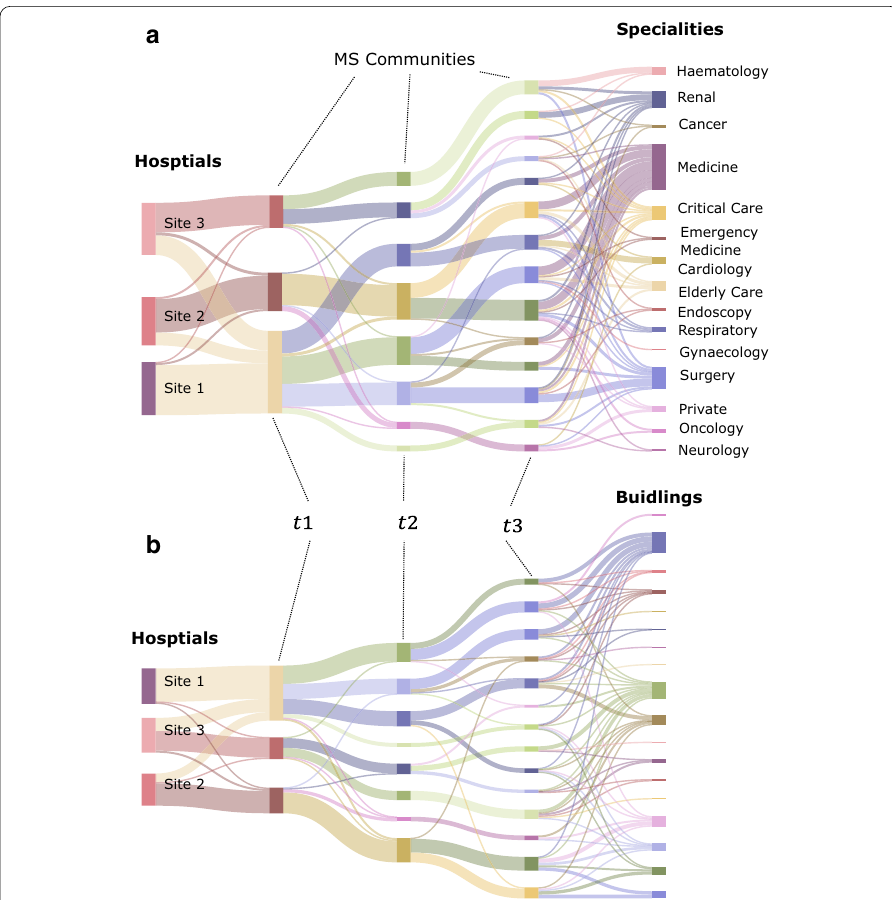
Fig. 6 Hierarchical breakdown of Markov Stability communities for three chosen scales t 1 , t 2 and t 3 (optimal partitions chosen for their robustness after a detailed Markov Stability analysis, see Additional file 1: Fig. S4) and the relations of: (left) coarse partitions to Hospital sites; and (right) granular partitions to a specialities